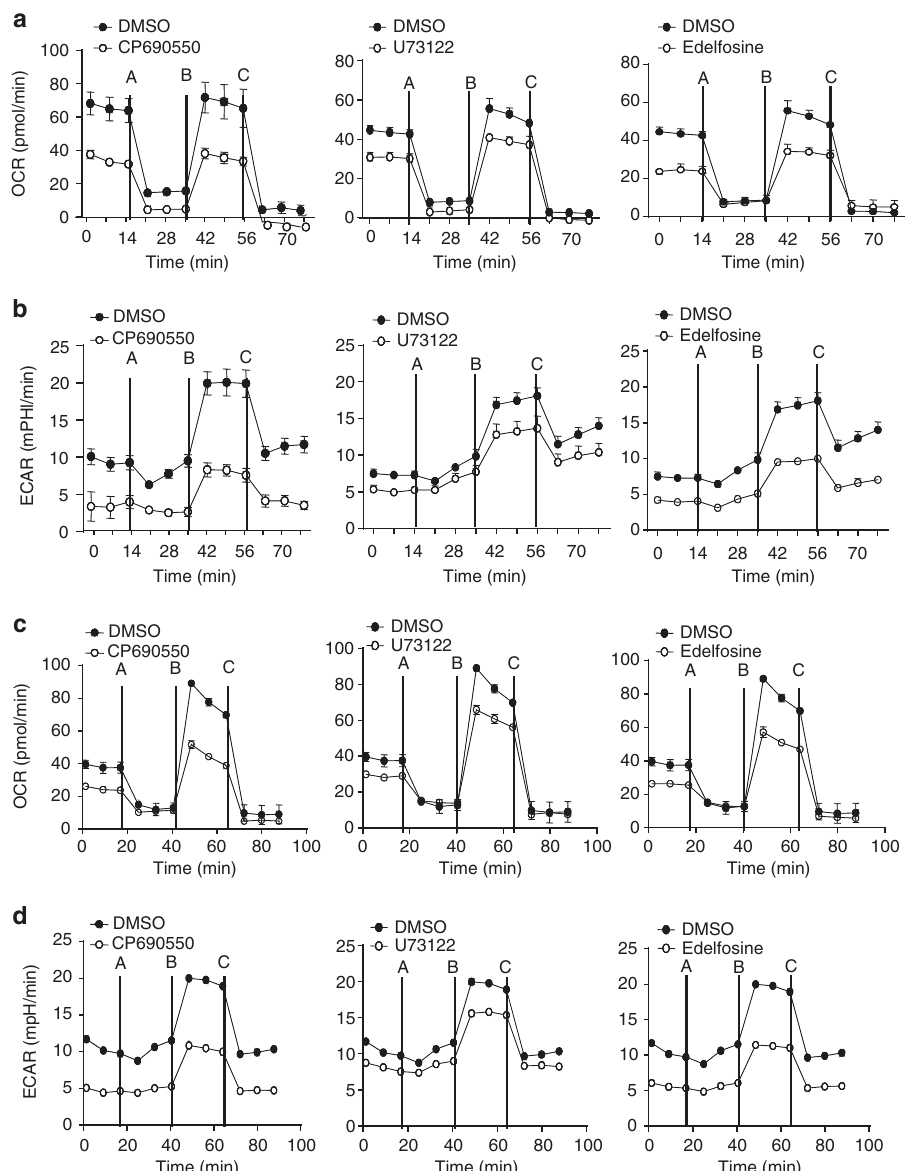
Fig. 5 Inhibition of the PLC γ pathway impairs IL-7-mediated metabolism of B cell progenitors. a , b BM − derived Rag1-de fi cient B cell progenitors were cultured with IL-7 plus DMSO, CP690550, U73122, or edelfosine. c , d B220 + IgM − IL-7R + B cell progenitors were sorted from wild-type mice and cultured without IL-7 (medium) or with IL-7 plus DMSO, CP690550, U73122, or edelfosine. After measuring basal OCR ( a , c ) and ECAR ( b , d ), oligomycin A (A), FCCP (B), and antimycin (C) were sequentially added. Error bars show ± SEM. Data shown are obtained from 5 ( a , b ) and 3 ( c , d ) independent experimentsED: On your fi gures please ensure all instances of PLCy refer to proteins, and < Emphasis Type = "Italic" > Plcg < /Emphasis > is used to refer to the